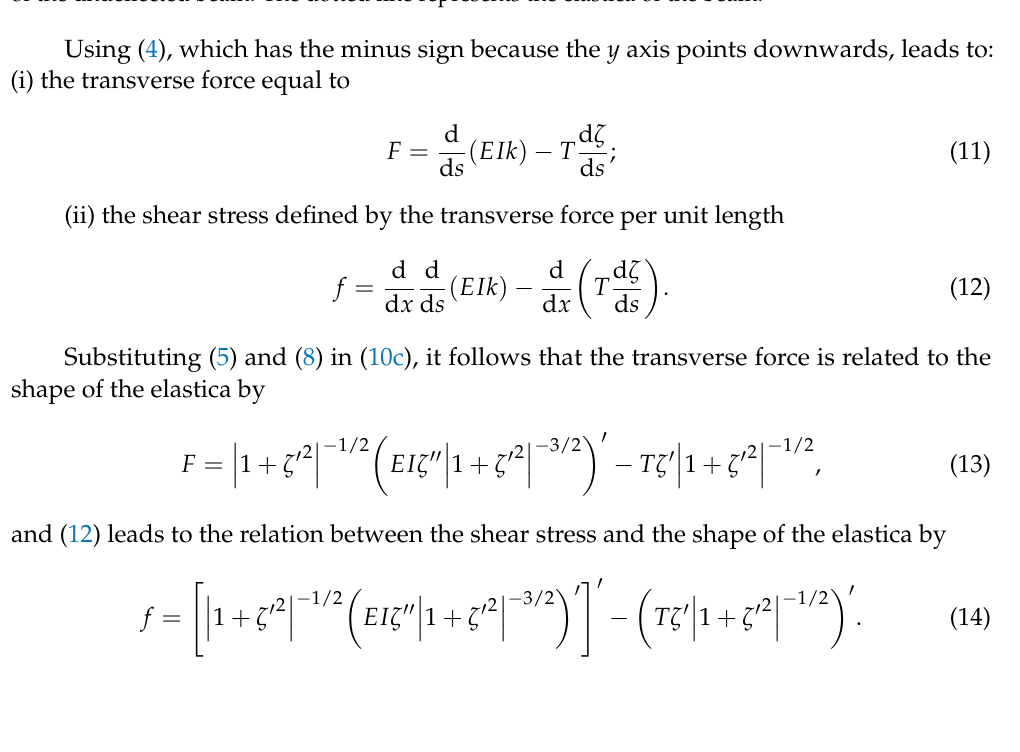
Figure 5. Sketch of the tangential force and its components with respect to the ( x , y ) reference frame of the undeflected beam. The dotted line represents the elastica of the